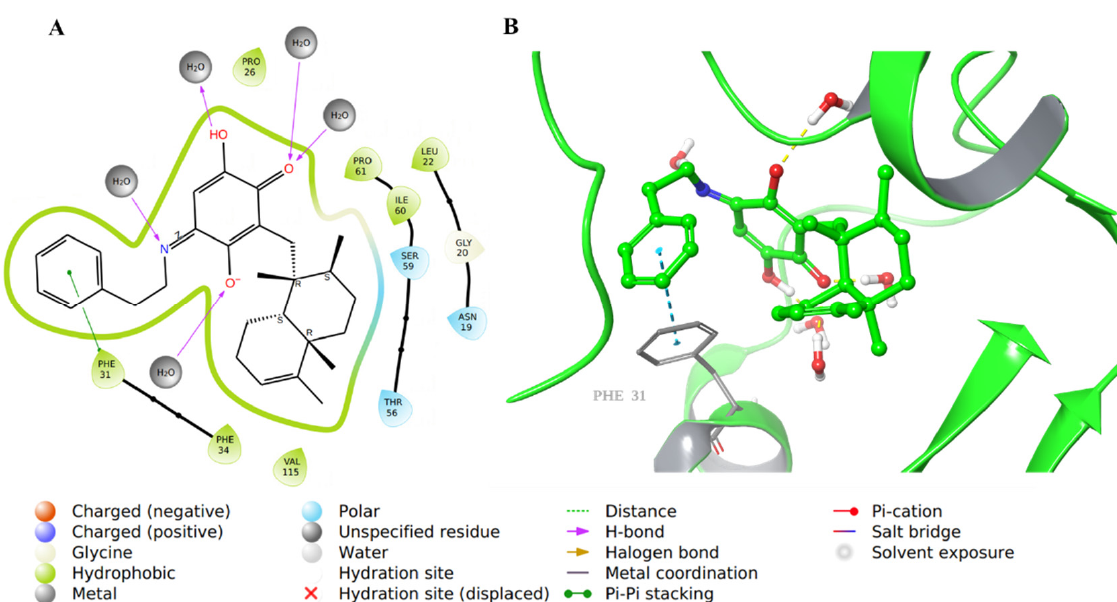
Figure 9. Molecular docking of co-crystallized inhibitor compound 28 in hDHFR (PDB: 1KMV). ( A ) 2D representation of binding interactions of 28 with amino acid residues in the active site within a 3 Å distance; ( B ) 3D representation of 28 in green within the hDHFR active site. The H-bonds and ionic interactions are in yellow and purple dotted lines, respectively.